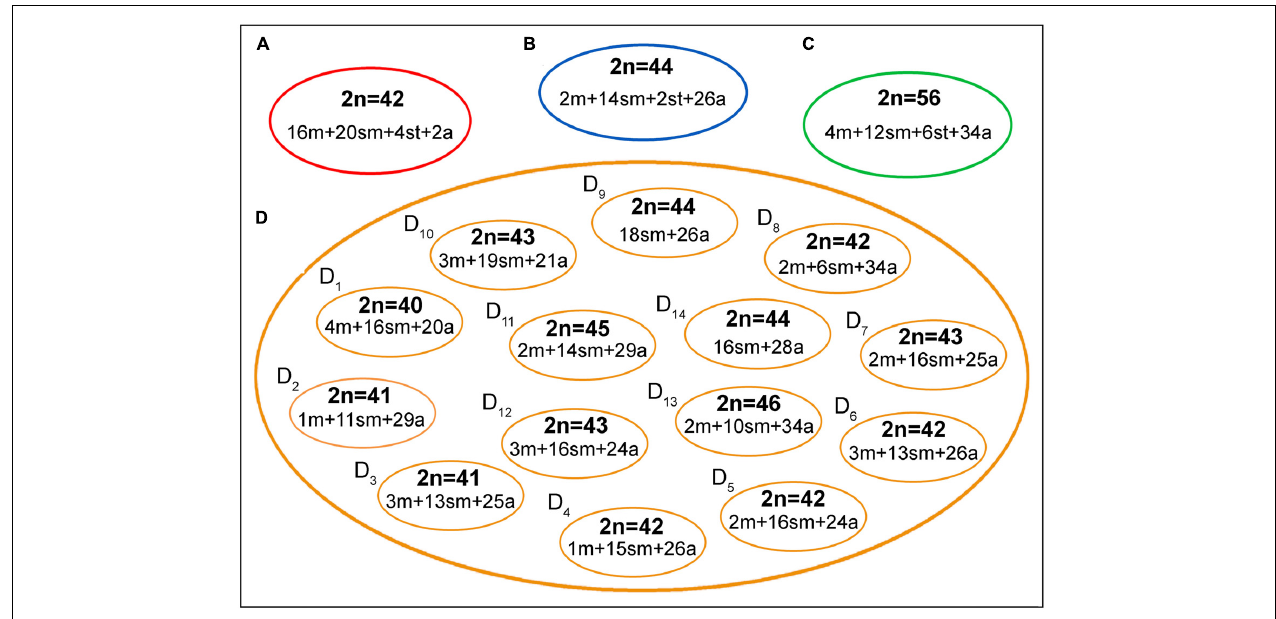
FIGURE 7 | A general overview on the chromosomal heterogeneity on B. coracoideus . (A) ESU-A Igarapé Jundiá – Cuieiras River, (B) SEU-B Demini River, (C) SEU-C Igarapé Apeú – Guamá River, and (D) SEU-D 1 − 14 Purus River.